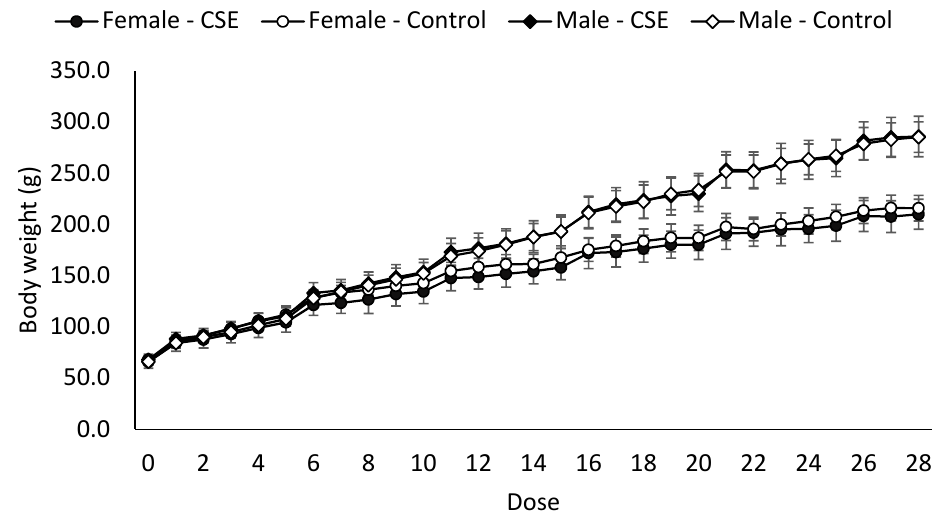
Figure 1. Body weight (g) of controls and rats treated with coffee silverskin extracts (CSE).